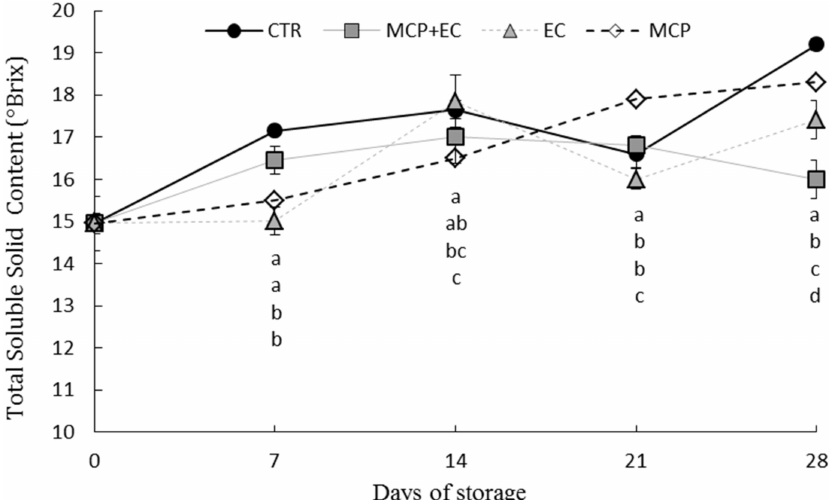
Figure 1. Evolution of fruit total soluble solids content ( ◦ Brix) in white flesh melting peaches ( P. persica ) cv Settembrina treated with the edible coating (EC), with 1-MCP + EC, 1-MCP (MCP) and untreated (CTR) stored at 1 ◦ C for 7, 14, 21 28 days. Data correspond to the means ± standard error (SE) of 15 replicates. Means with di ff erent letters are significantly di ff erent at p ≤ 0.05 using Tukey’s test. ns = not significant. Di ff erent lowercase letters denote significant di ff erences ( p ≤ 0.05) among di ff erent treatments for the same sampling time.